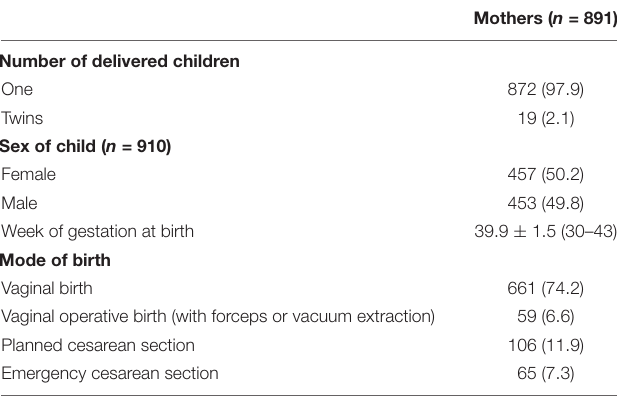
TABLE 4 | Birth-related characteristics of the INVITE study